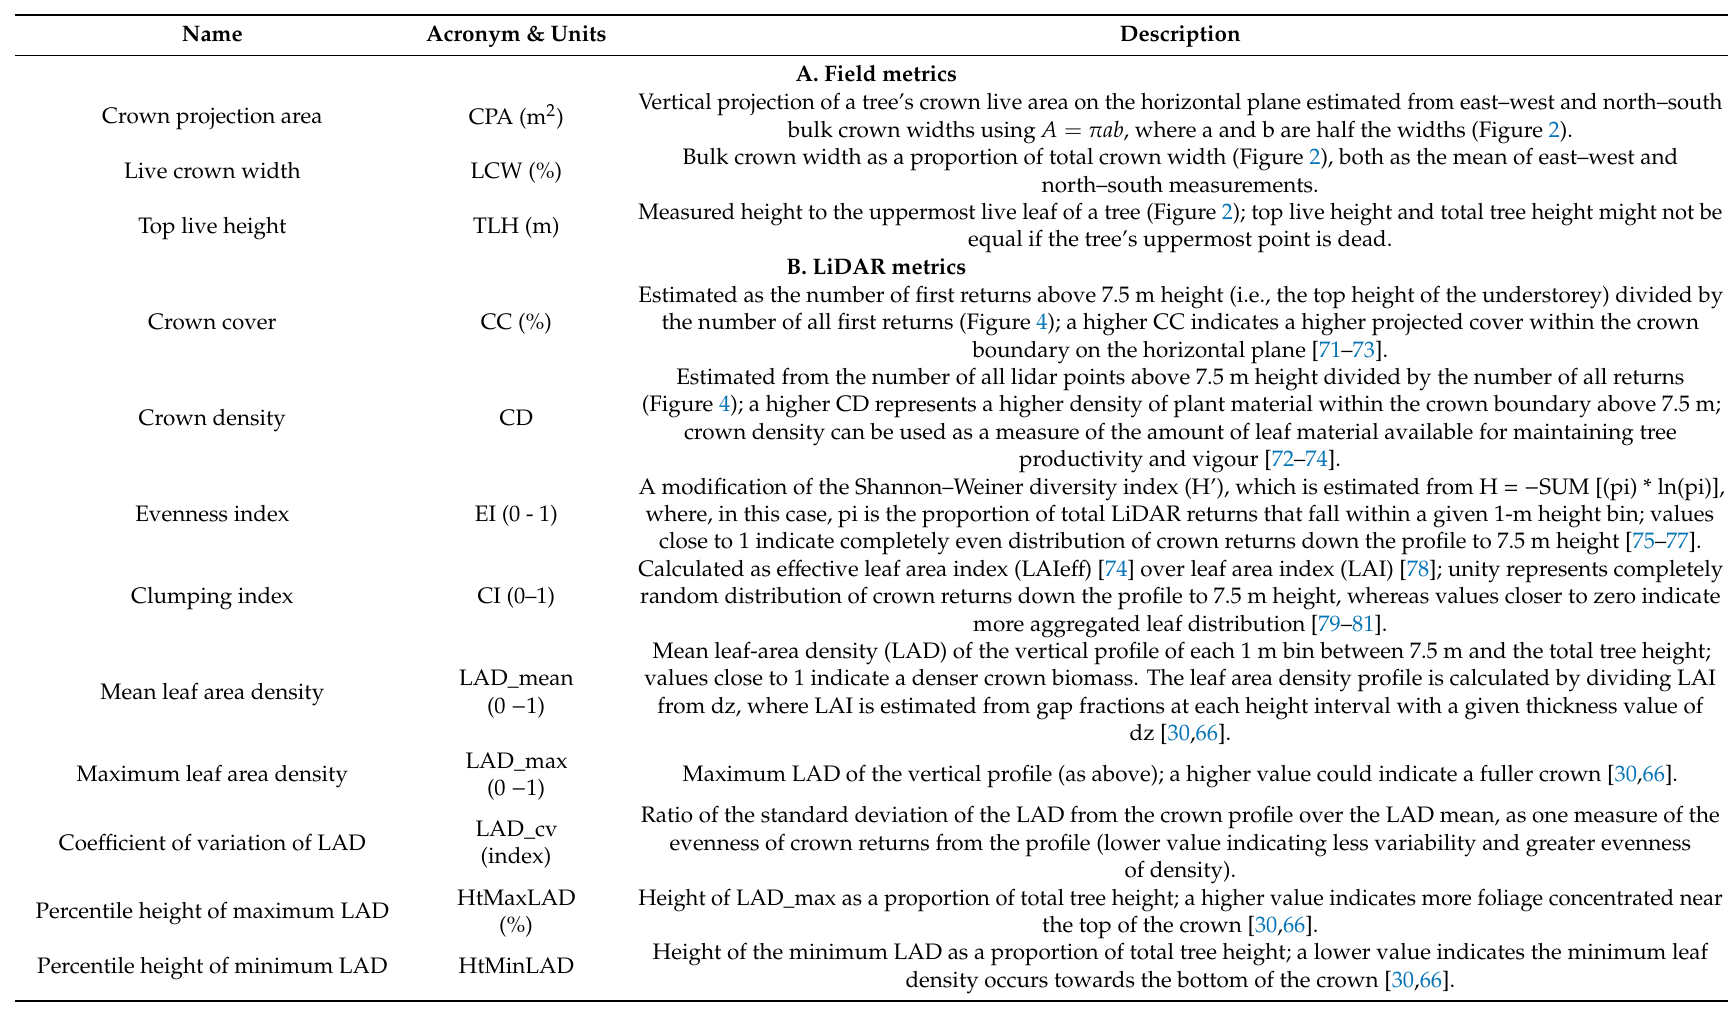
Table 1. Horizontal and vertical crown metrics assessed for A) field-assessed trees (n = 342) and for B) trees delineated in LiDAR data (n = 196) across four fire-severity types (unburnt, low, moderate,